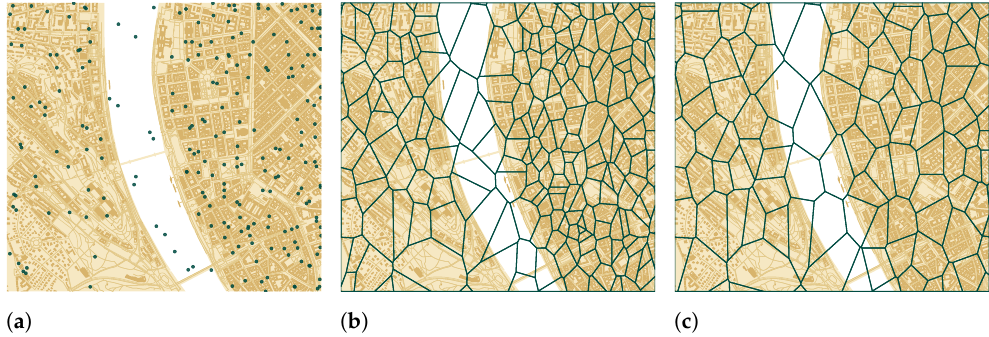
Figure 6. Mixed cell centroid ( a ), Voronoi polygons using the original cells ( b ), and Voronoi polygons after merging the close cells ( c ).